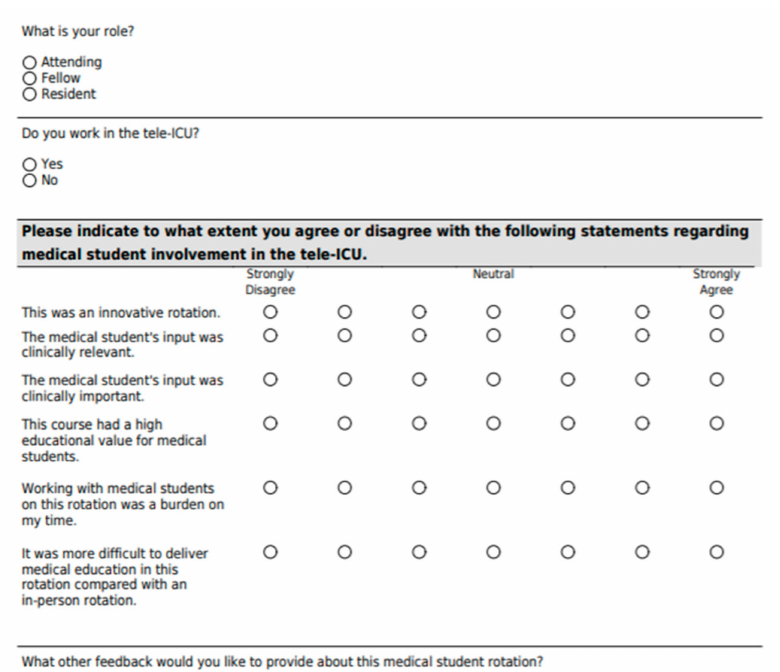
Figure A2. Healthcare Provider End-Of-Rotation